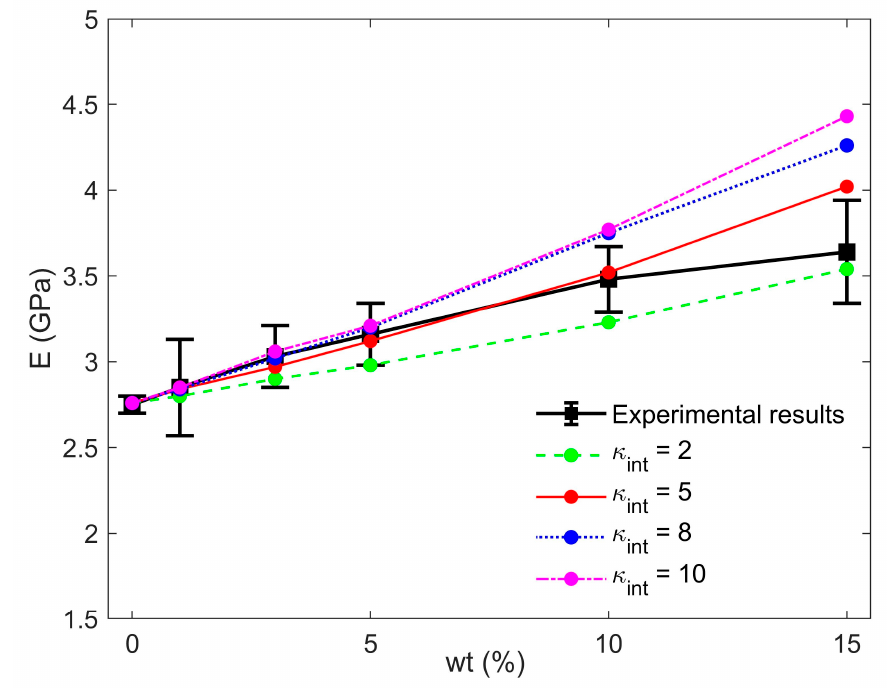
Figure 10. Results of the PD-based RVE approach calibration.